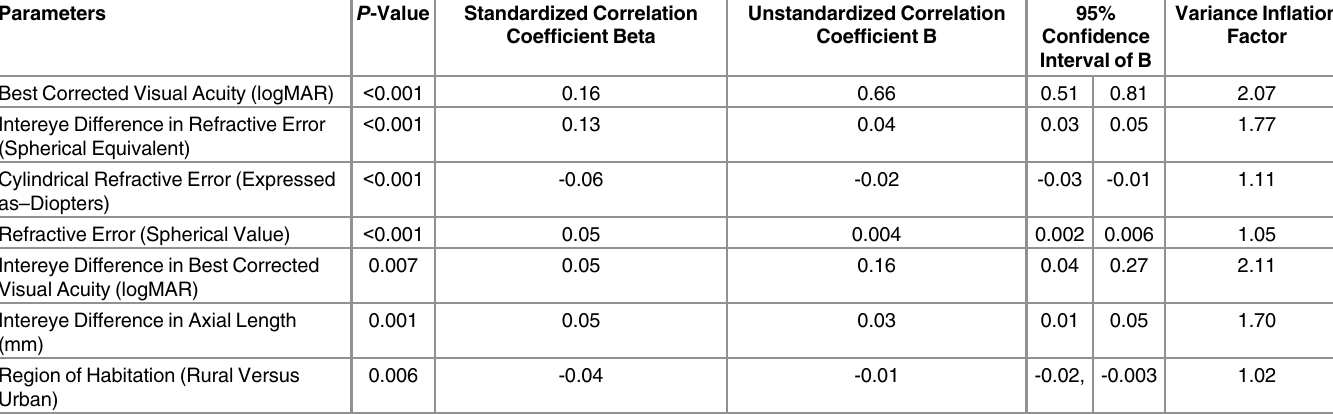
Table 4. Associations (Multivariate Analysis) between Stereoacuity (Expressed as Logarithm of the Measured Angle of Binocular Disparity) and Systemic and Ocular Parameters in the Shandong Children Eye